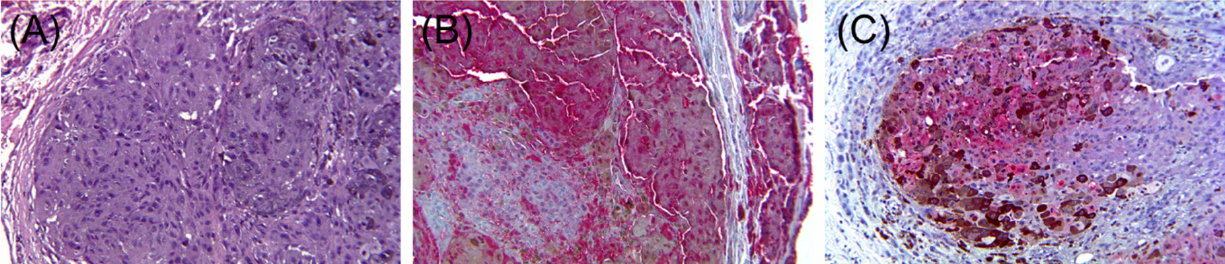
Figure 4. Malignant melanoma ( A , H & E 20). Lesional cells are positive for S100 ( B , immunohistochemical stain 20) and low molecular weight keratin ( C , immunohistochemical stain 20).